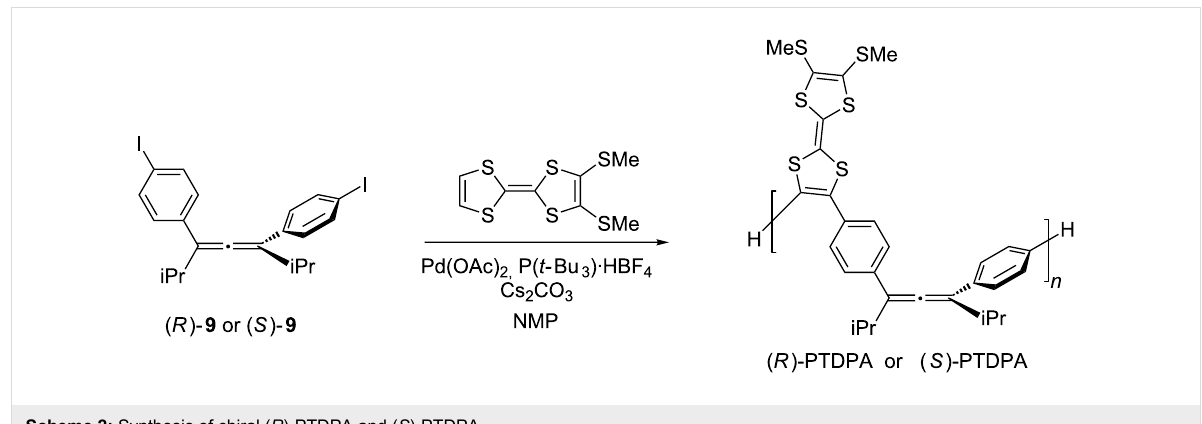
Scheme 2: Synthesis of chiral ( R )-PTDPA and ( S )-PTDPA.